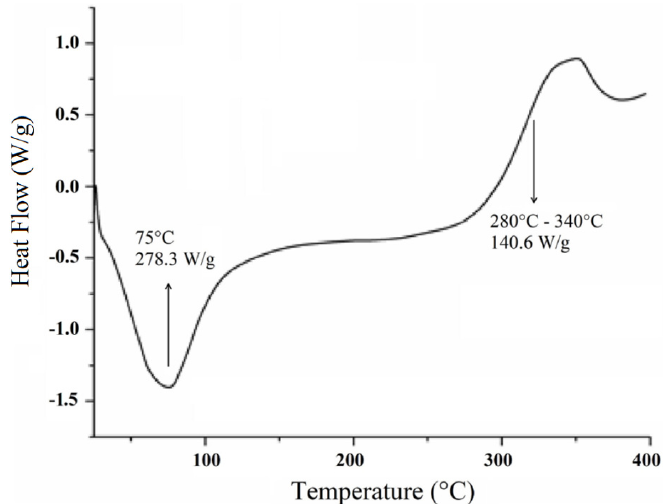
Figure 4. Differential scanning calorimetry (DSC) curve for cellulose extracted from Opuntia ficus ‐ indica L. Miller.